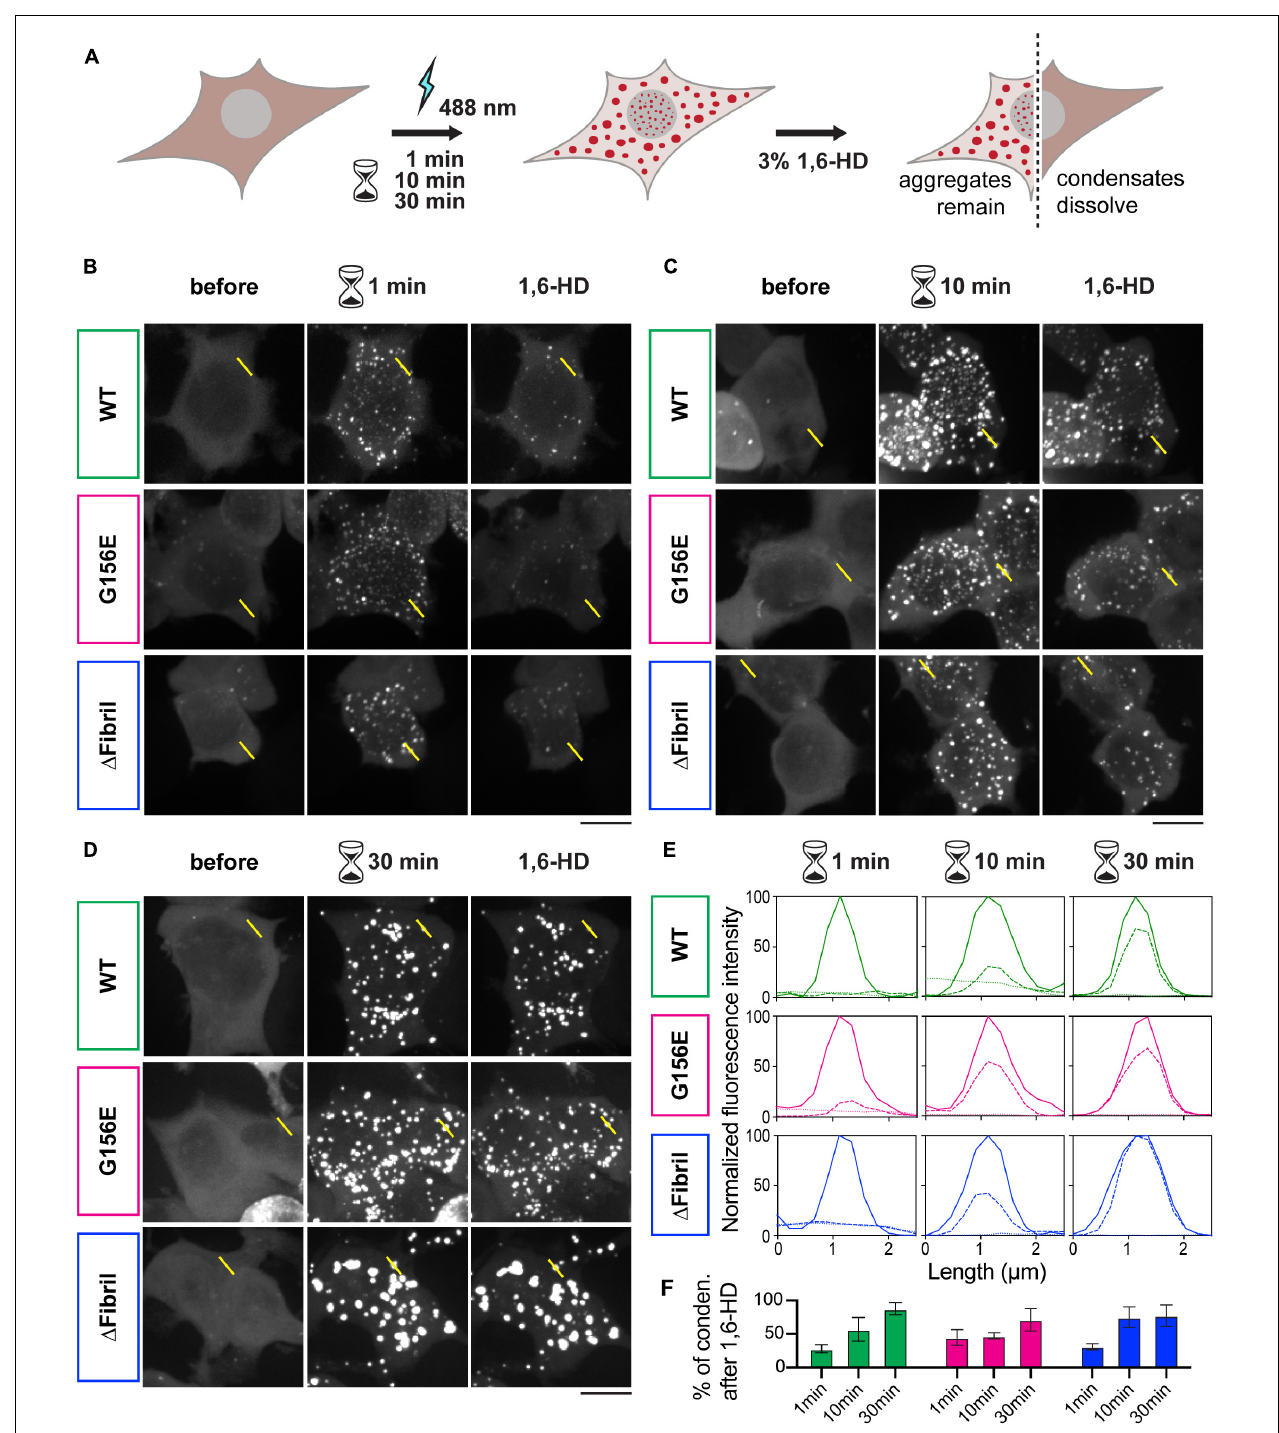
FIGURE 3 | Continuous photoactivation results in the formation of solid-like FUS condensates. (A) Scheme of the imaging-based assay for the formation of FUS condensates coupled to 1,6-hexanediol (1,6-HD) for dissecting whether condensates have liquid- or solid-like properties. (B) Images (z-projections) of wild-type FUS (top), FUS G156E (middle) and (cid:49) Fibril (bottom) before, after 1 min photoactivation at 0.15 mW 488 nm-laser power at the output, and upon the addition of 3% 1,6-HD. (C) Same as in B, but photoactivation for 10 min. (D) Same as in (B) , but photoactivation for 30 min. Scale bars, 10 µ m. (E) Line profiles of highlighted regions in B-D (dotted line, before activation; full line, after activation; dashed line, after 1,6-hexanediol treatment). (F) Fractions of condensates that remain after 1,6-hexanediol treatment (green, Cry2-FUS wild-type; magenta, Cry2-FUS G156E; blue, Cry2-FUS (cid:49) Fibril). Bars represent average values with standard deviation; each experiment is done in three independent rounds of